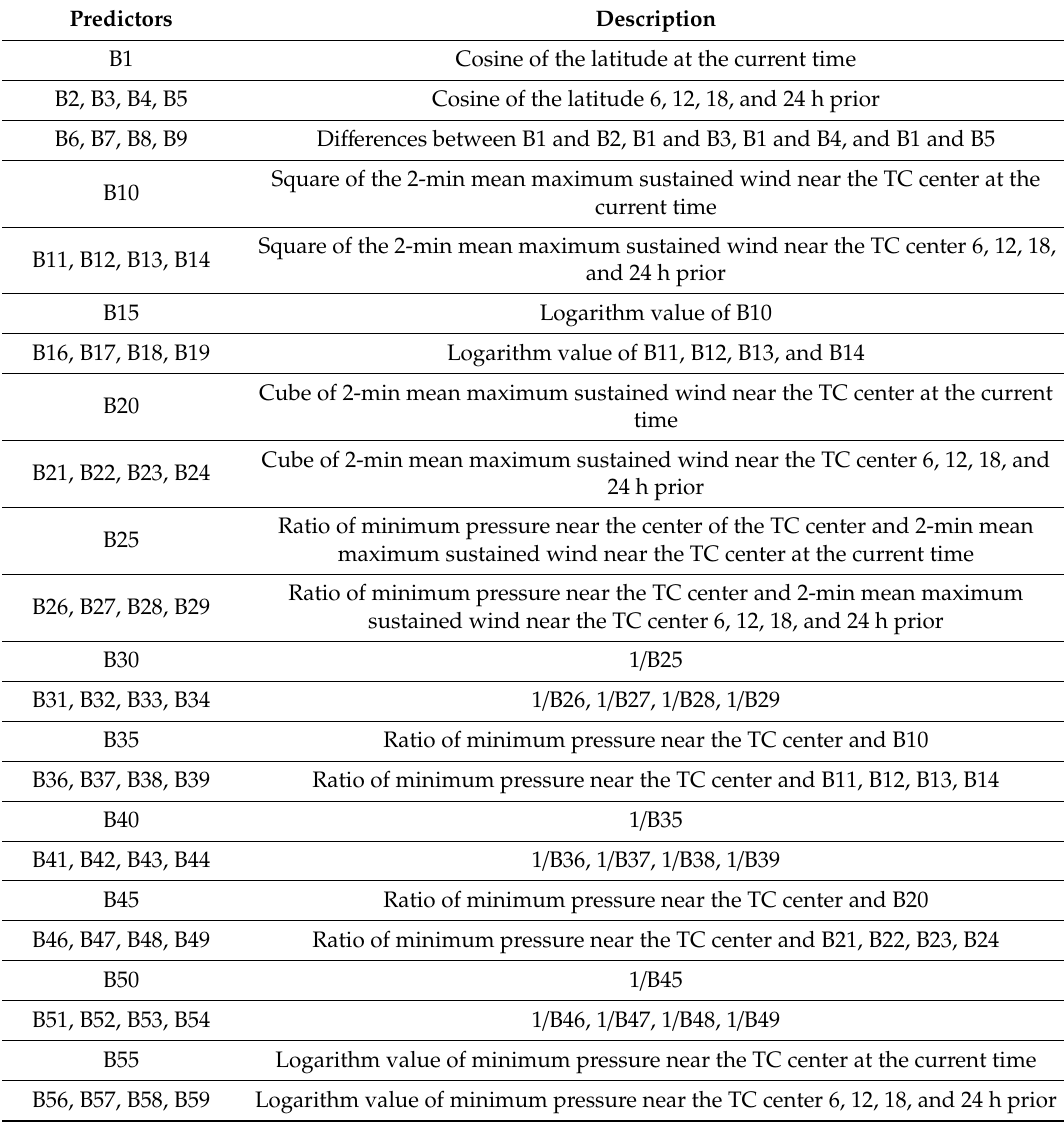
Table 4. Detailed description of the 59 brainstorm